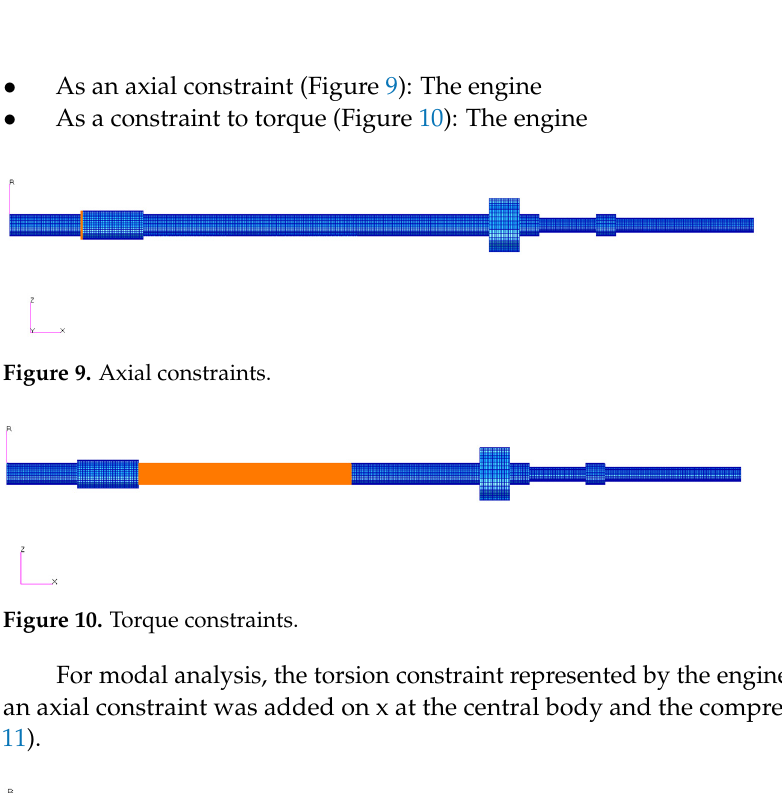
Figure 10. Torque constraints.